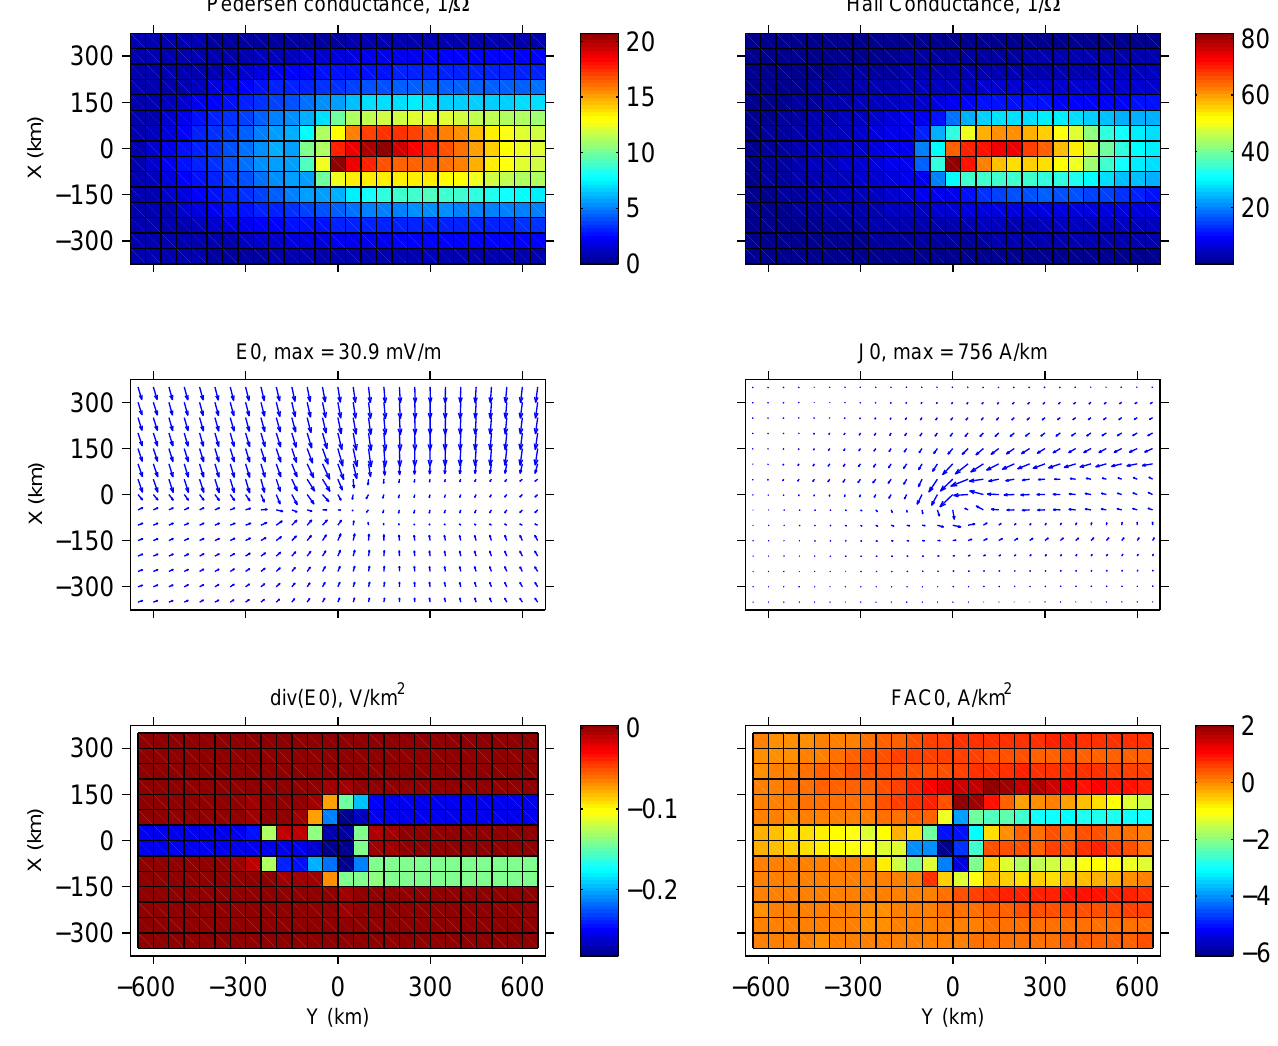
Fig. 8. The WTS model. Layout is similar to Fig. 5. Note the different scales of the vector plots.